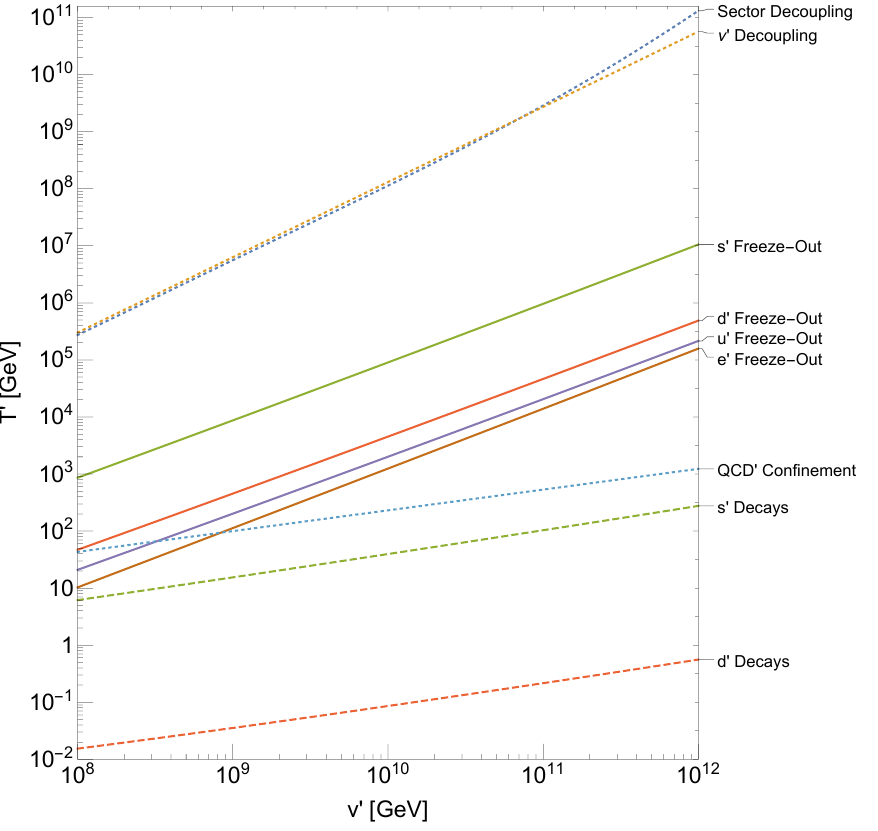
Figure 8 . Temperatures of the mirror bath around which each mirror fermion freezes-out (solid) and decays (dashed). Mirror temperatures of sector decoupling, (cid:23) 0 decoupling, as well as the mirror QCD phase transition, are shown as dotted